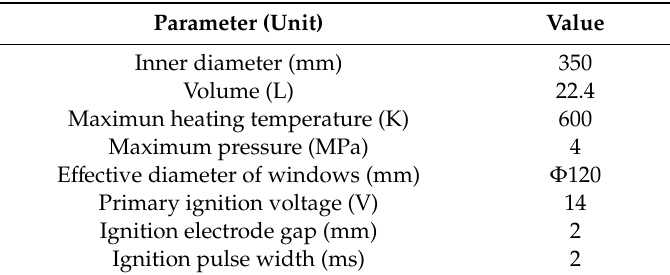
Table 1. Parameters of the constant volume